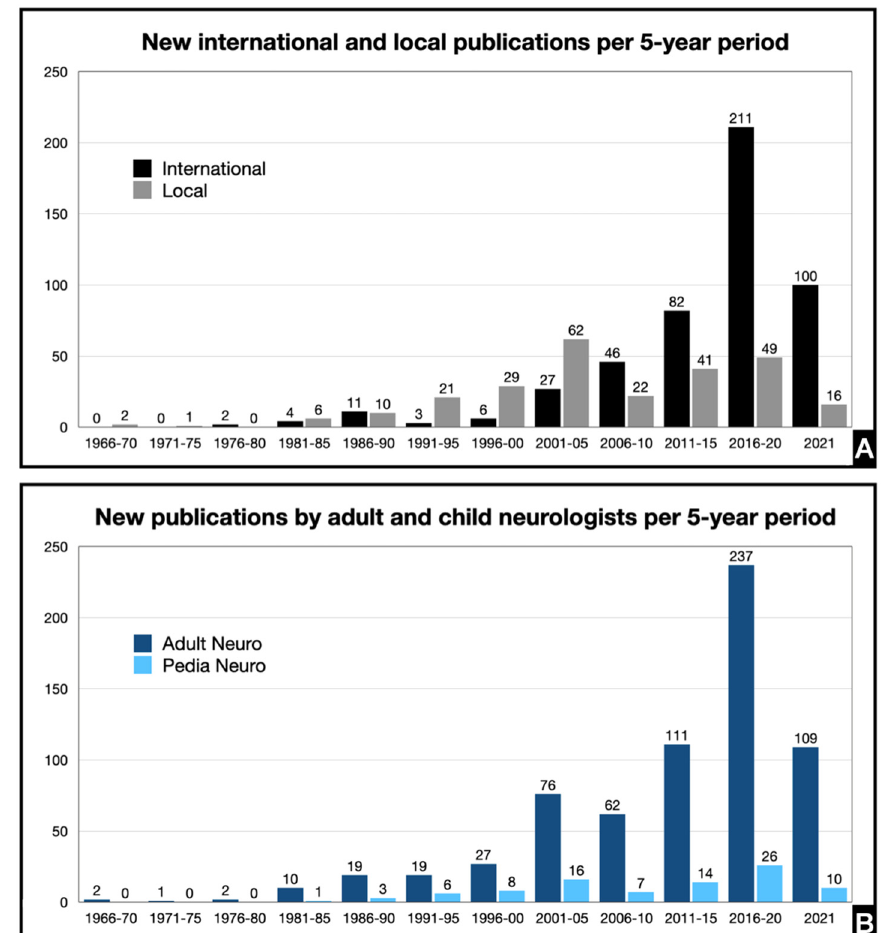
Figure 3. Trends in research publications of Filipino neurologists per 5-year period by journal of publication ( A ) and by field of practice ( B ).